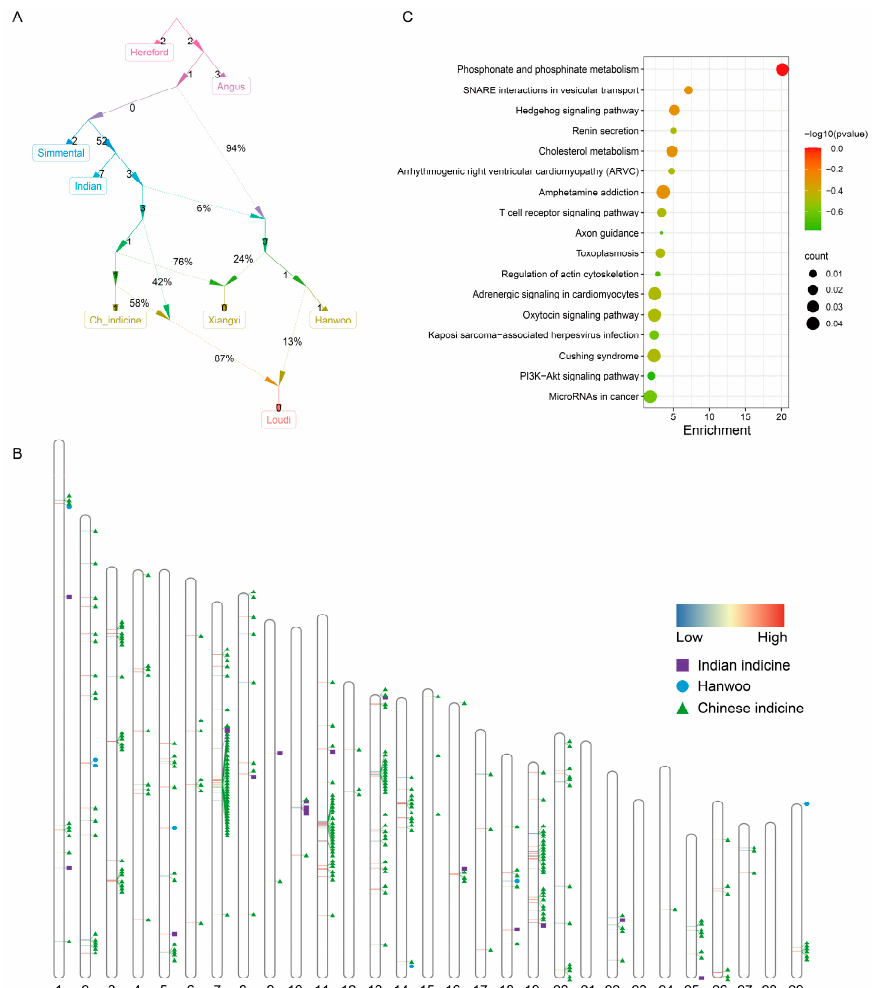
Figure 3. Admixture events and ancestry inference in Loudi cattle. ( A ) Iterative building of admix- ture graphs using Admixtools2-qpGraph. ( B ) Identification of the local segments in which propor- tions of a certain ancestry were significantly higher than the proportion in the whole genome in Loudi cattle. ( C ) The KEGG pathways from the enrichment analysis of genes with excessive Chinese indicine